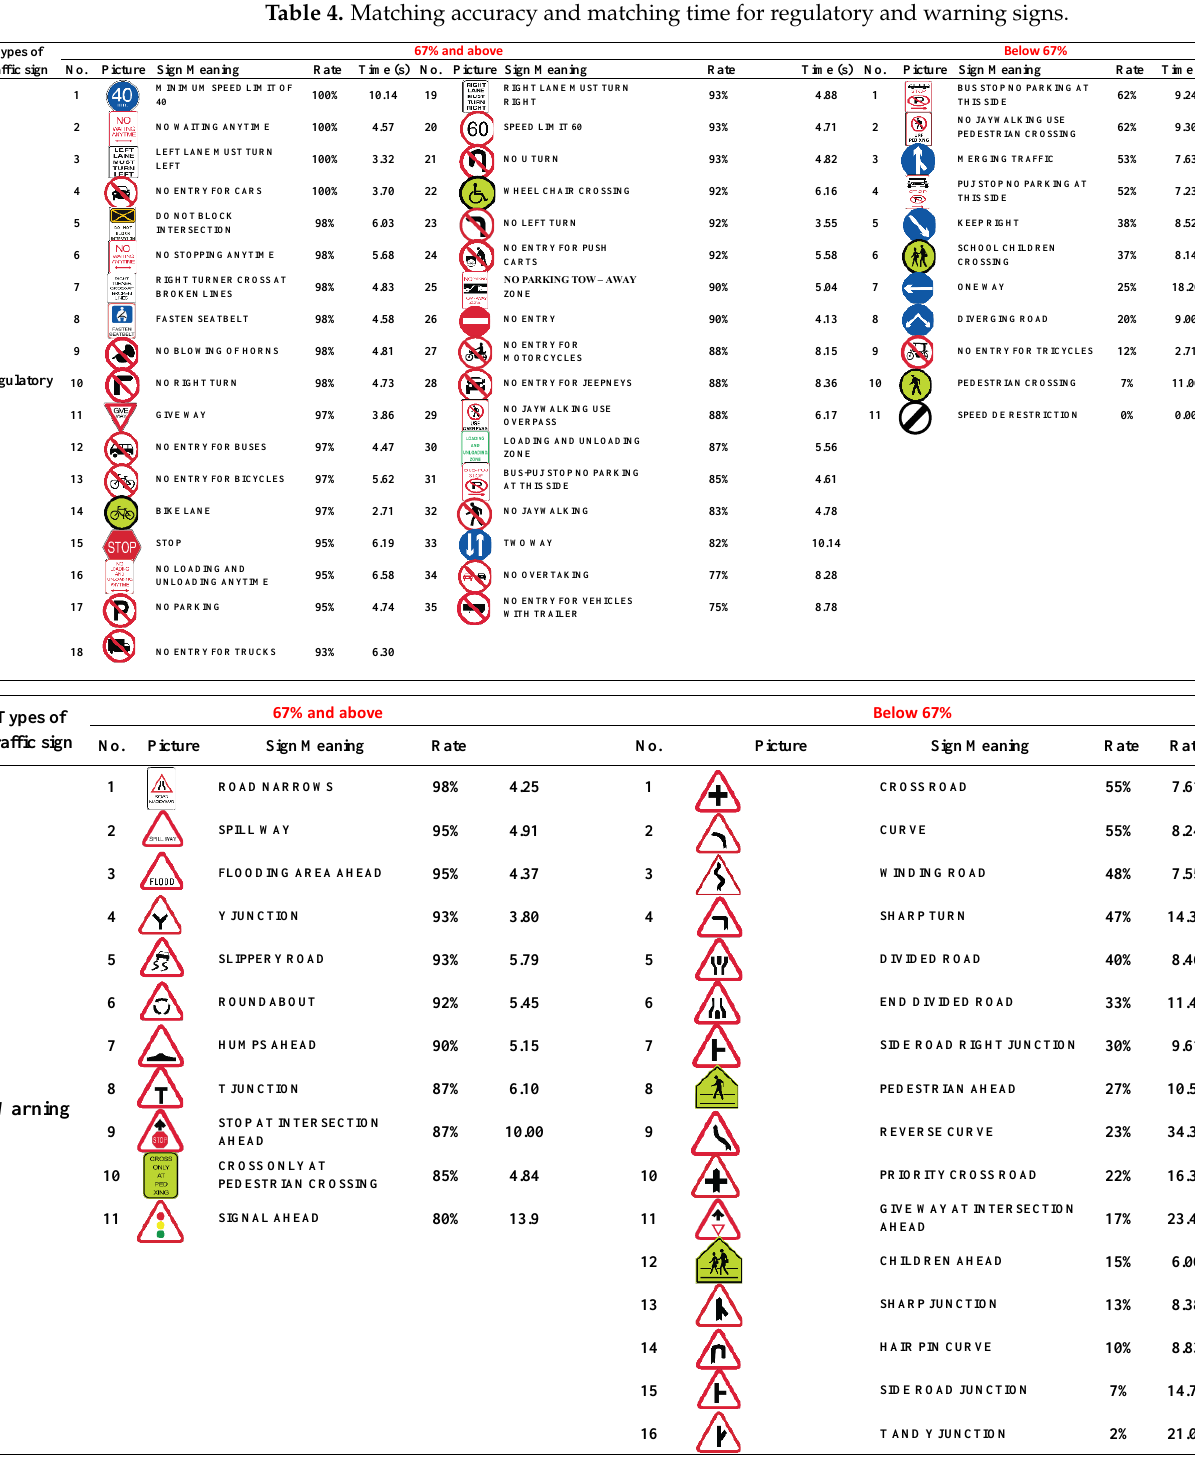
Table 4. Matching accuracy and matching time for regulatory and warning signs.